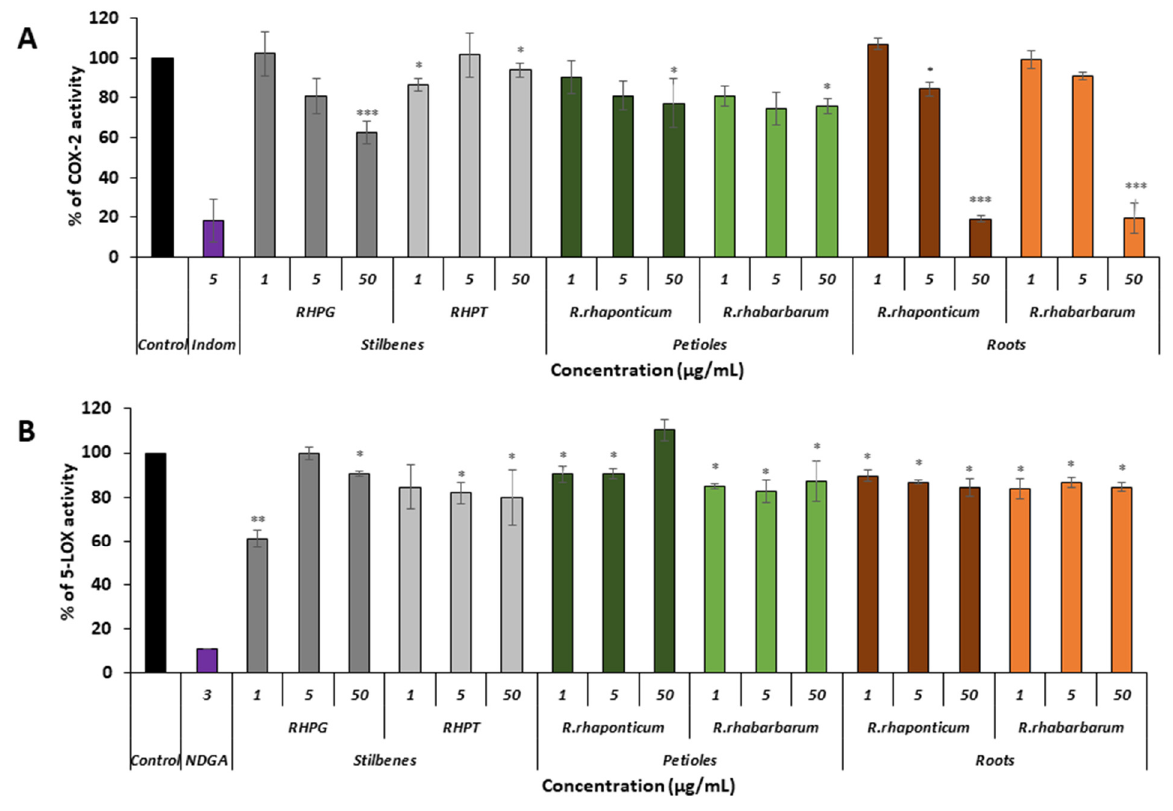
Figure 7. Effect of stilbenes (RHPG and RHPT) as well as the petiole and root extracts of Rheum rhaponticum and Rheum rhabarbarum on the activity of COX-2 (panel A ) and 5-LOX (panel B ); n = 7. The activity of native enzymes (untreated with any of the examined substances) was assumed as 100%; * p < 0.5; ** p < 0.01; *** p <